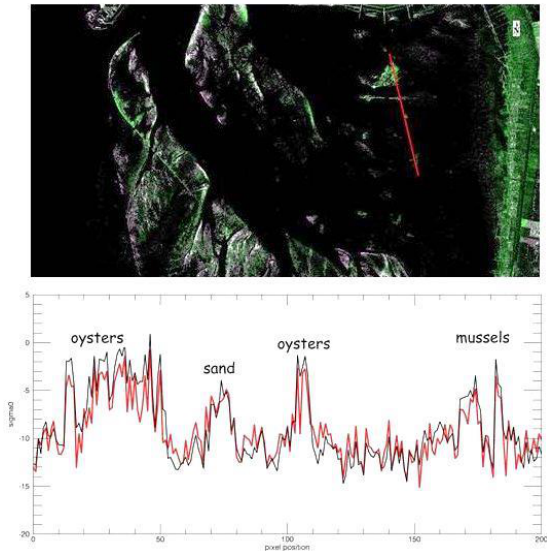
Figure 4. Temporal statistics for the test site “Jadebusen”. Upper: false color composite of the mean value (green) and the standard deviation (magenta); lower: downward transect (red line in the upper panel); black: mean; red: standard deviation Figure 2. Extended oyster bed in the test site “Jadebusen” (photograph: S. Melchionna) Green areas, therefore, correspond to a large mean NRCS exceeding the standard deviation, and in magenta areas the standard deviation exceeds the mean NRCS. The lower panel shows the respective values along the red scan line inserted in the upper panel, with the mean marked in black and the standard deviation marked in red. Highlighted are areas of oyster and mussel beds and of sandy flats, which were identified during field